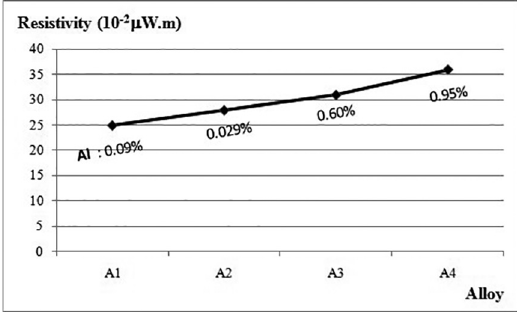
Figure 1: Electrical resistivity calculated by ASTM A 712-98 Standard.